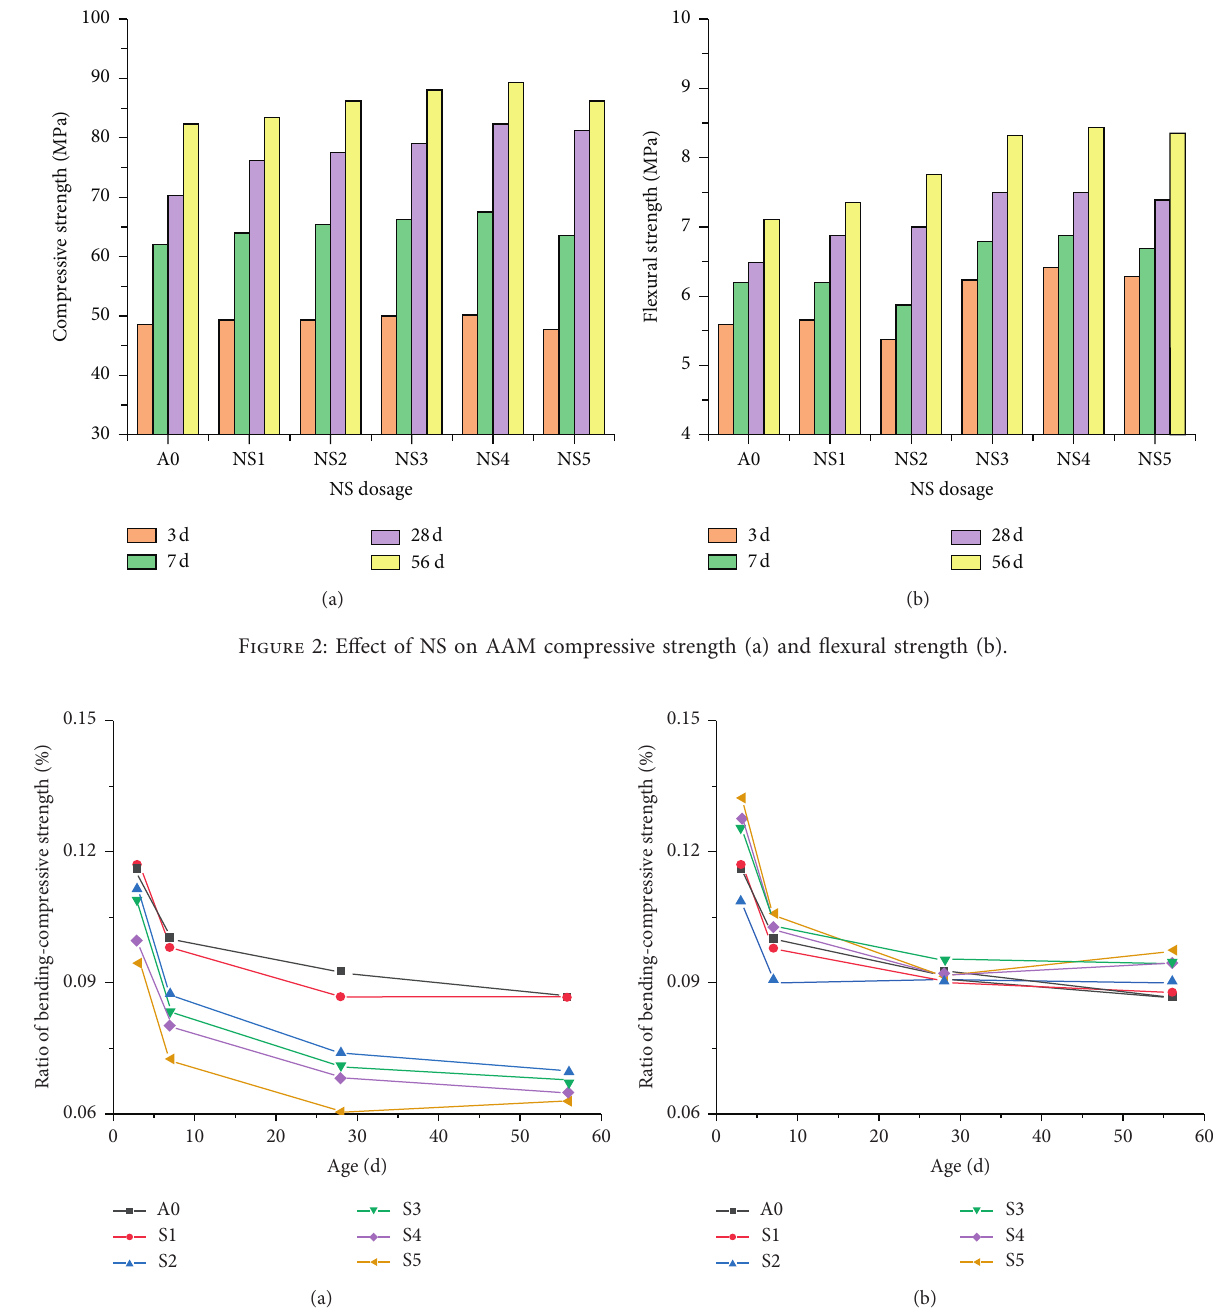
Figure 3: Effects of SF (a) and NS (b) on the compressive-flexural strength ratio